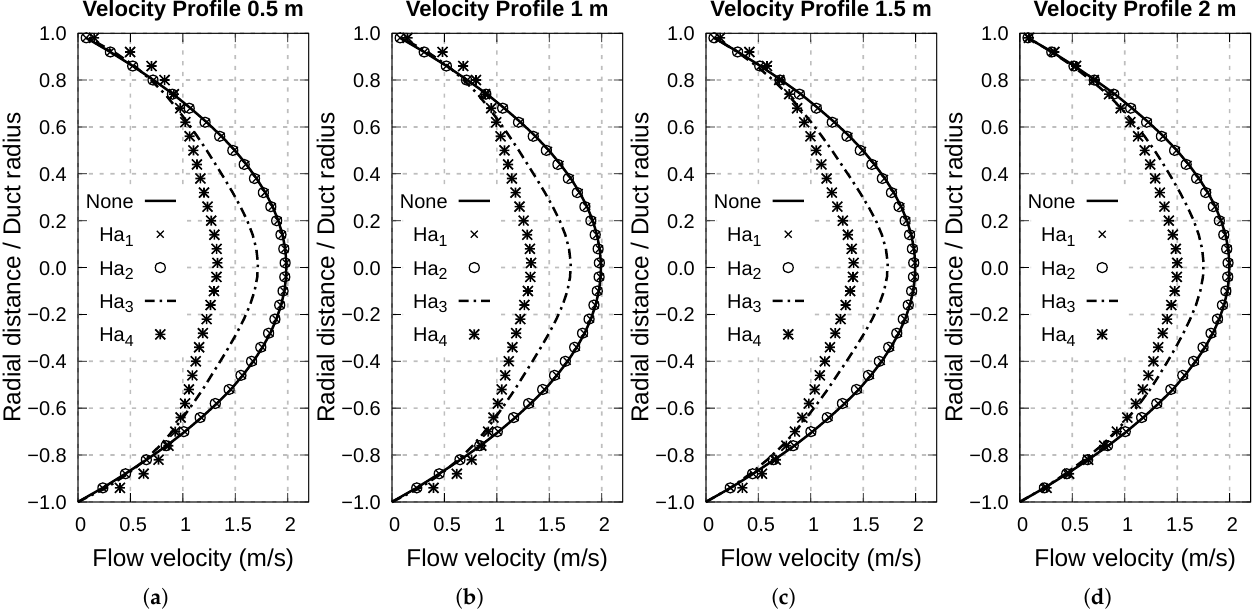
Figure 7. Velocity profiles of fluid flow in the duct at the positions ( a ) 0.5 m, ( b ) 1.0 m, ( c ) 1.5 m and ( d ) 2.0 m from the duct inlet. Magnets are in the repulsive